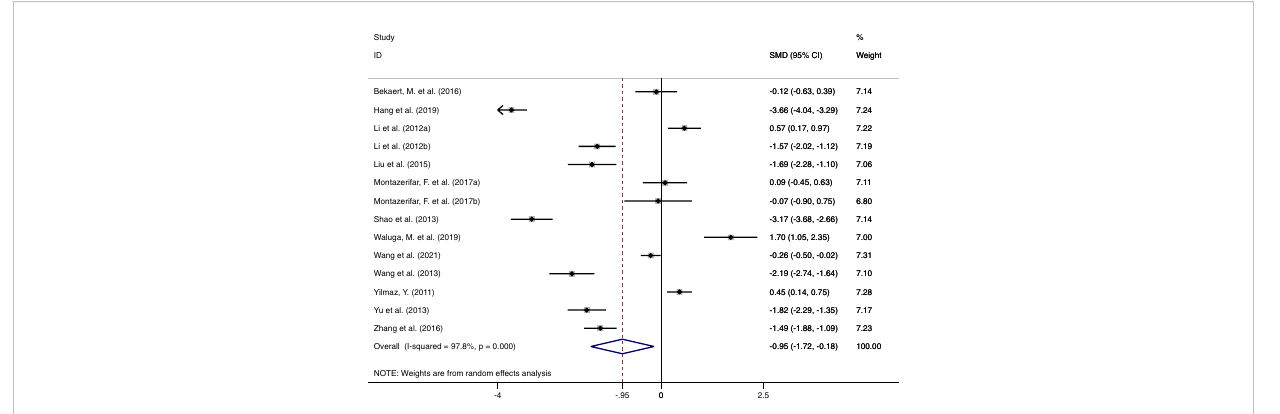
FIGURE 2 Forest plot presenting circulating omentin levels between MAFLD and healthy control group (Random-Effects Model, SMD ). The omentin levels were signi fi cantly reduced in patients with MAFLD groups than in healthy controls.